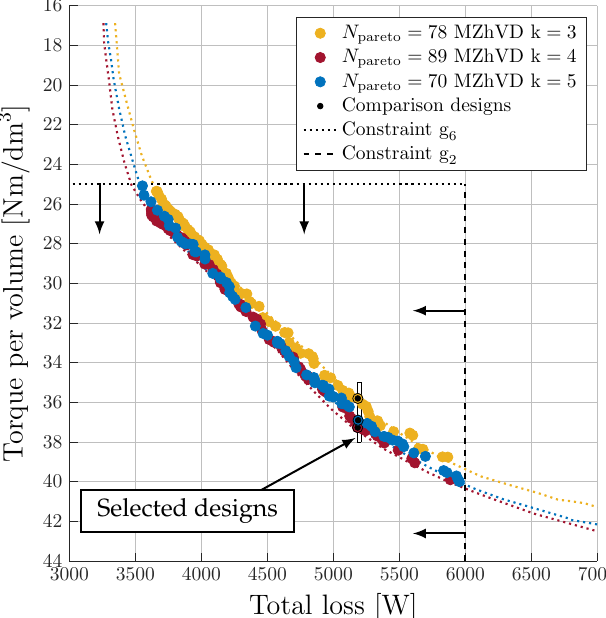
Figure 16. Validated MZhVD Pareto front for k = 3–5 within constraints g 2 and g 6 . Dotted colored lines represent estimated Pareto fronts. N pareto is the number of designs placed on each